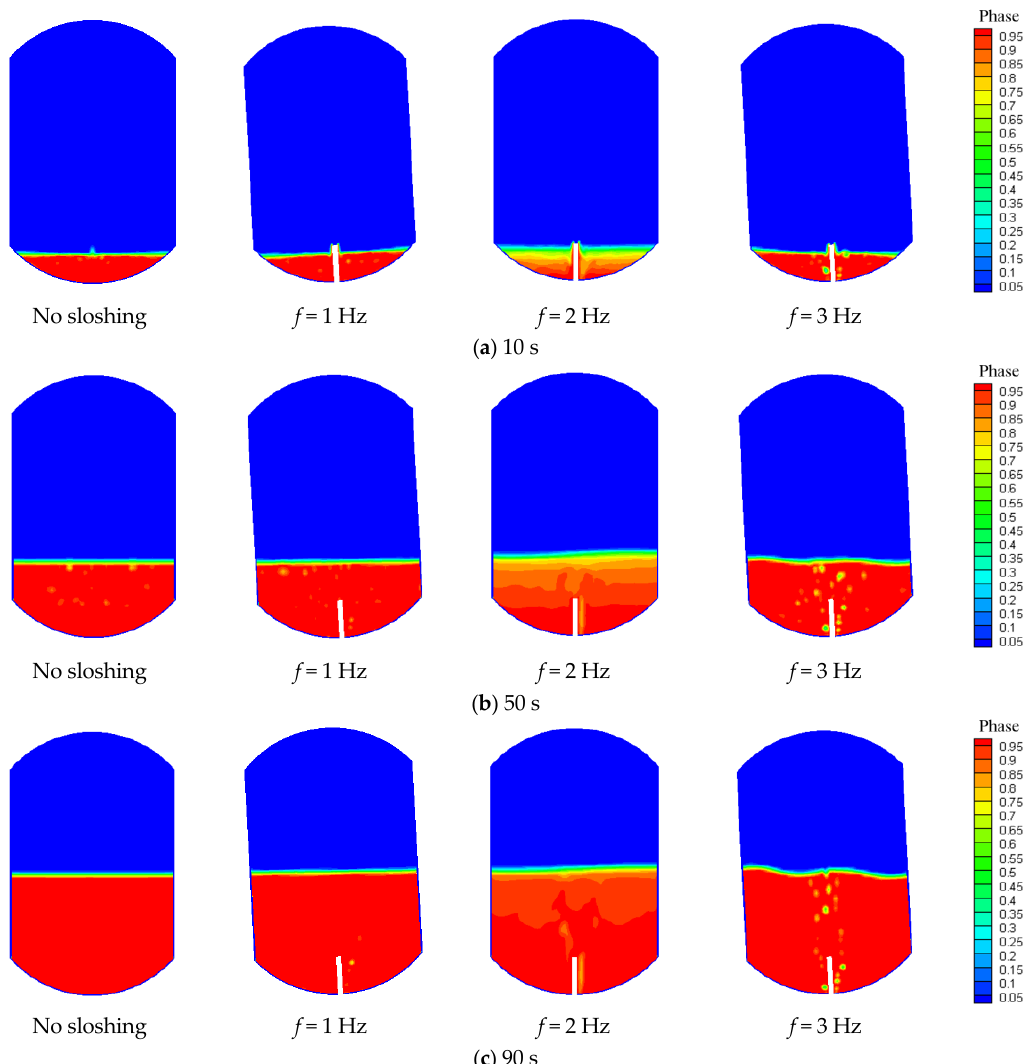
Figure 11. Graphic contours of phase distribution under di ff erent sloshing frequencies ( A = 0.03 m)